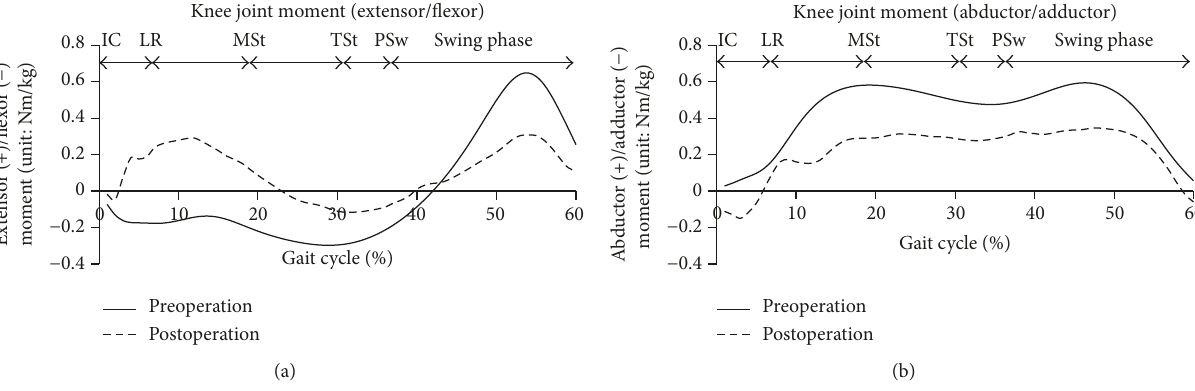
Figure3: Pre-andpostoperativekneejointmoments. (a)representskneeextensor-flexorand(b)representskneeadductor-abductormoment during gait